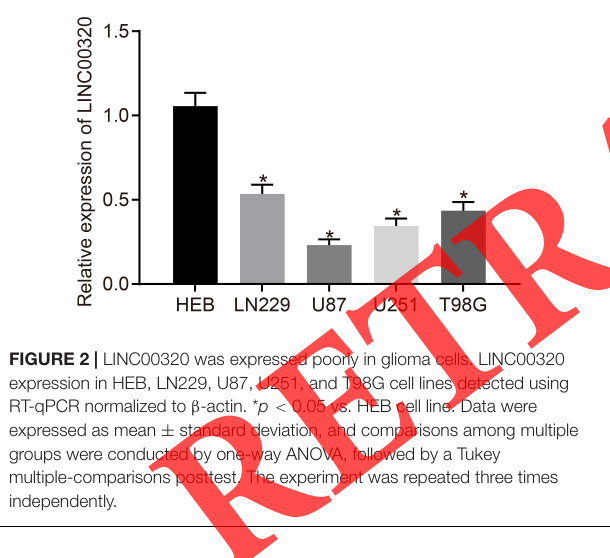
The table indicates statistical results from χ 2 analysis. LINC00320, long intergenic non–protein-coding RNA 320; and WHO, World Health Organization.